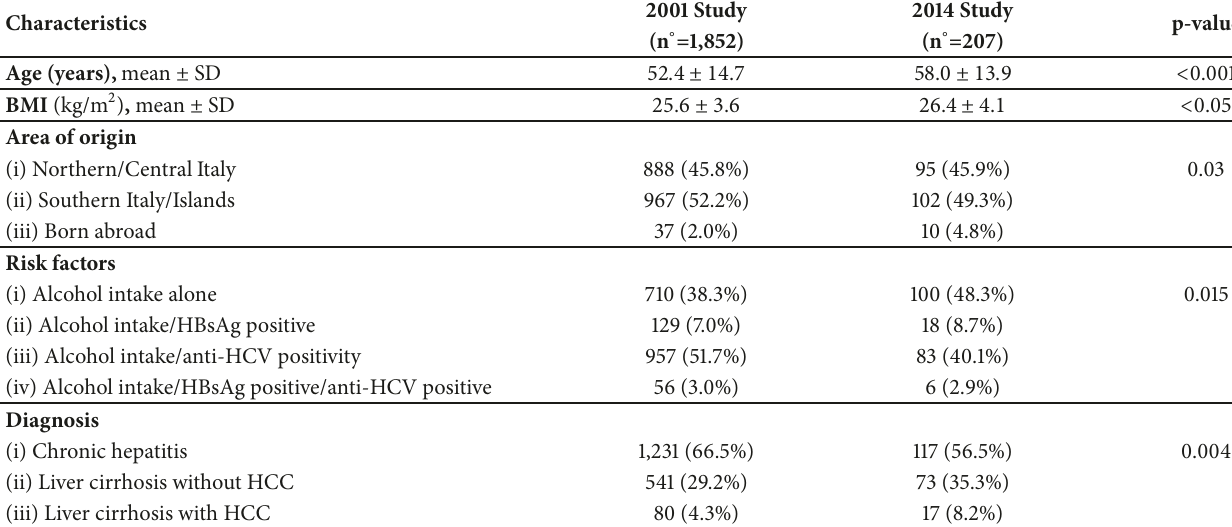
Table 3: Characteristics of chronic liver diseases alcohol related in male sex over time in Italy.